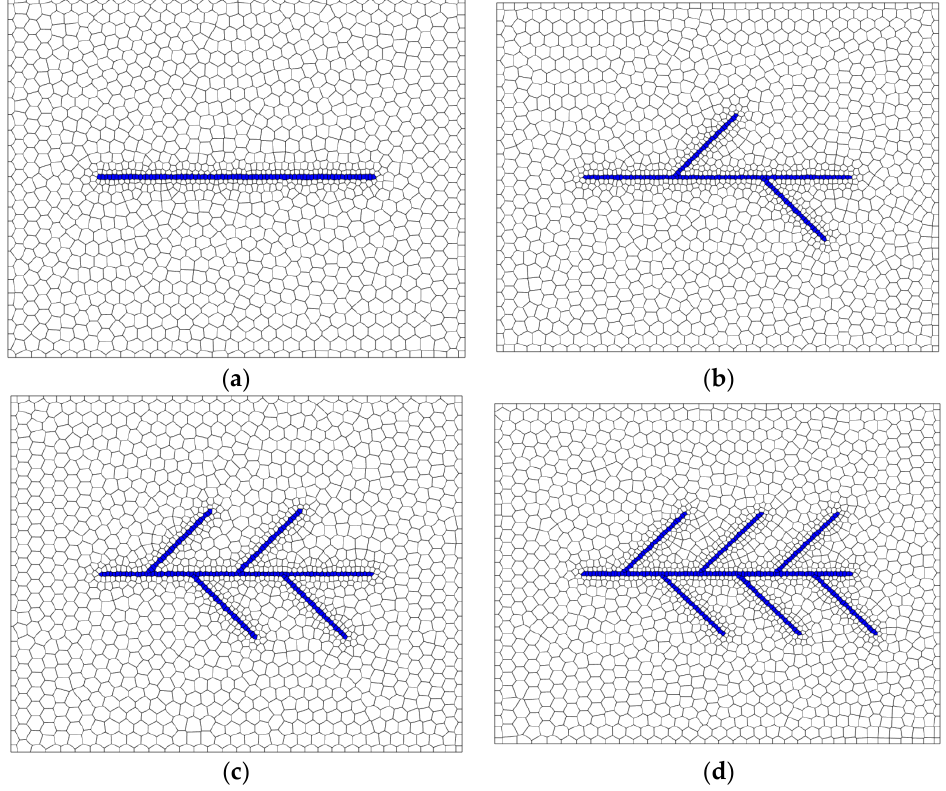
Figure 2. ( a ) Single horizontal well, ( b ) two-branch fishbone well, ( c ) four-branch fishbone well, ( d ) six-branch fishbone well. PBEI unstructured meshing.